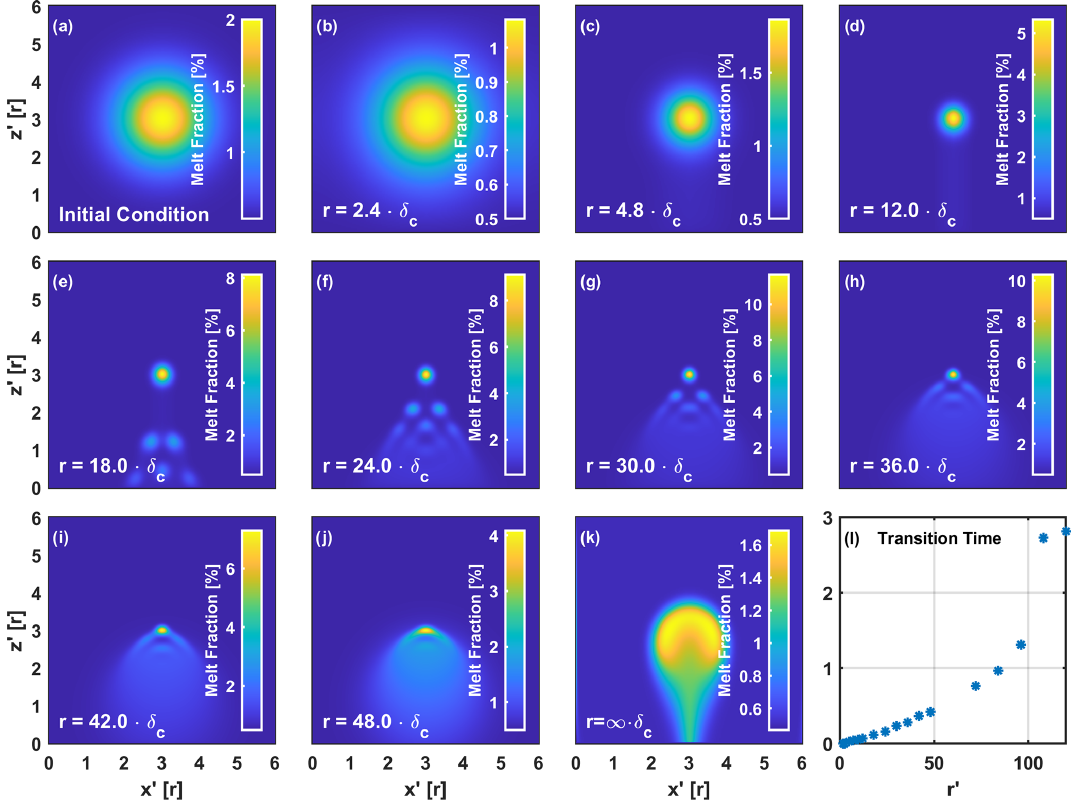
Figure 3. Melt ascent morphology as function of initial perturbation radius in terms of compaction length. (a) Initial conditions of the model are valid for all cases apart of the change in compaction length. (b–j) Melt fraction distribution after t (cid:48) = 02 for length scale ratios varying between 2.4 and 48. (k) Diapiric rise resulting from a compaction length of zero at t (cid:48) = 9. (l) Model transition time as a function of length scale ratios varying between 1.8 and 120. The transition time gives the time after which the main wave has reached solitary-wave